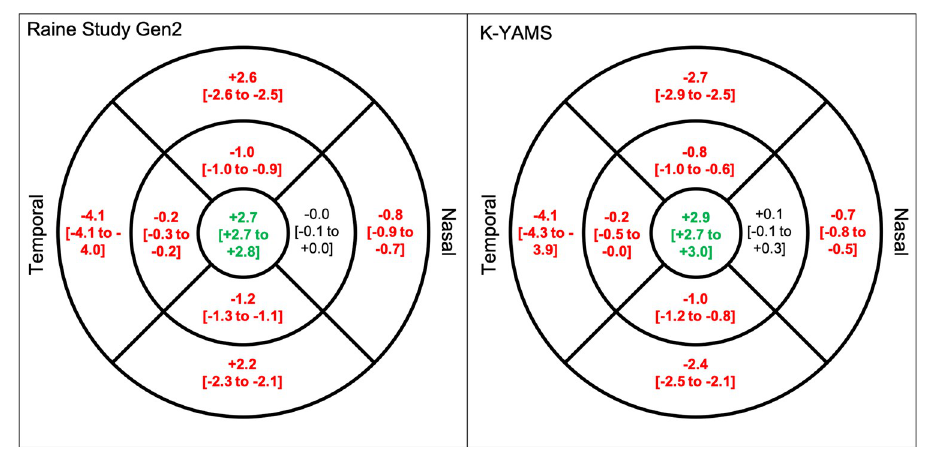
Fig 5. Under- and overestimation of retinal thickness ( μ m) per 1mm increase in axial length by the raw measurements, relative to the transverse magnification-corrected thickness [and 95% confidence interval] in (left) the Raine Study Gen2 (mean axial length = 23.6 ± 0.9 mm) and (right) K-YAMS participants (mean axial length = 23.6 ± 1.1 mm). Note that the mean axial length of both cohorts is shorter than that assumed by the Spectralis SD-OCT (24.385 mm). Significant interaction effects (p < 0.05) shown in bold and red (underestimation) or green (overestimation). Adjusted for sex and ethnicity. https://doi.org/10.1371/journal.pone.0266909.g005 outside the central macula, albeit at generally smaller magnitudes than observed with the raw measurements ( Table 2 ). These findings indicate that the effect of longer or shorter axial length on macular thickness may be smaller than previously reported, but still statistically sig- nificant. At the central macula, there was no association between retinal thickness and axial length found when using the raw measurements. However, a negative association between reti- nal thickness and axial length was observed in both cohorts with the corrected measurements. At the outer inferior, temporal and superior regions, longer axial length was associated with thinner retinal thickness before, but not with the corrected measurements.